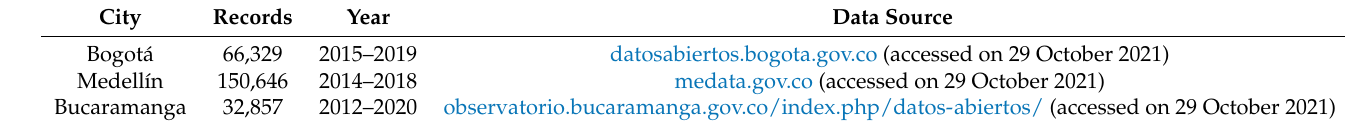
Table 5. Raw Data Information.